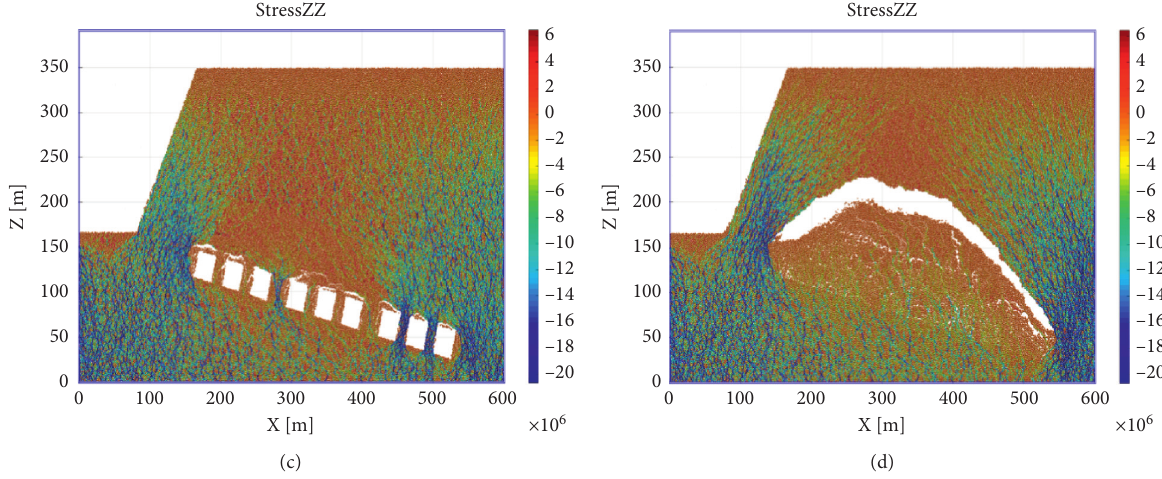
Figure 10: The stress distribution of the excavated rock mass in (a) the first stage, (b) the second stage, (c) the third stage, and (d) the stoping